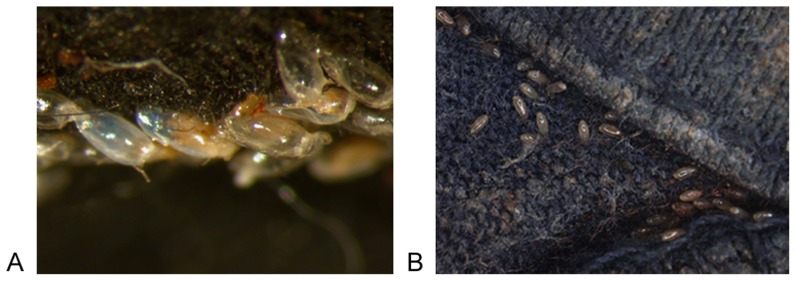
Lice eggs attached to a homeless cap (A) and a homeless collar (B).